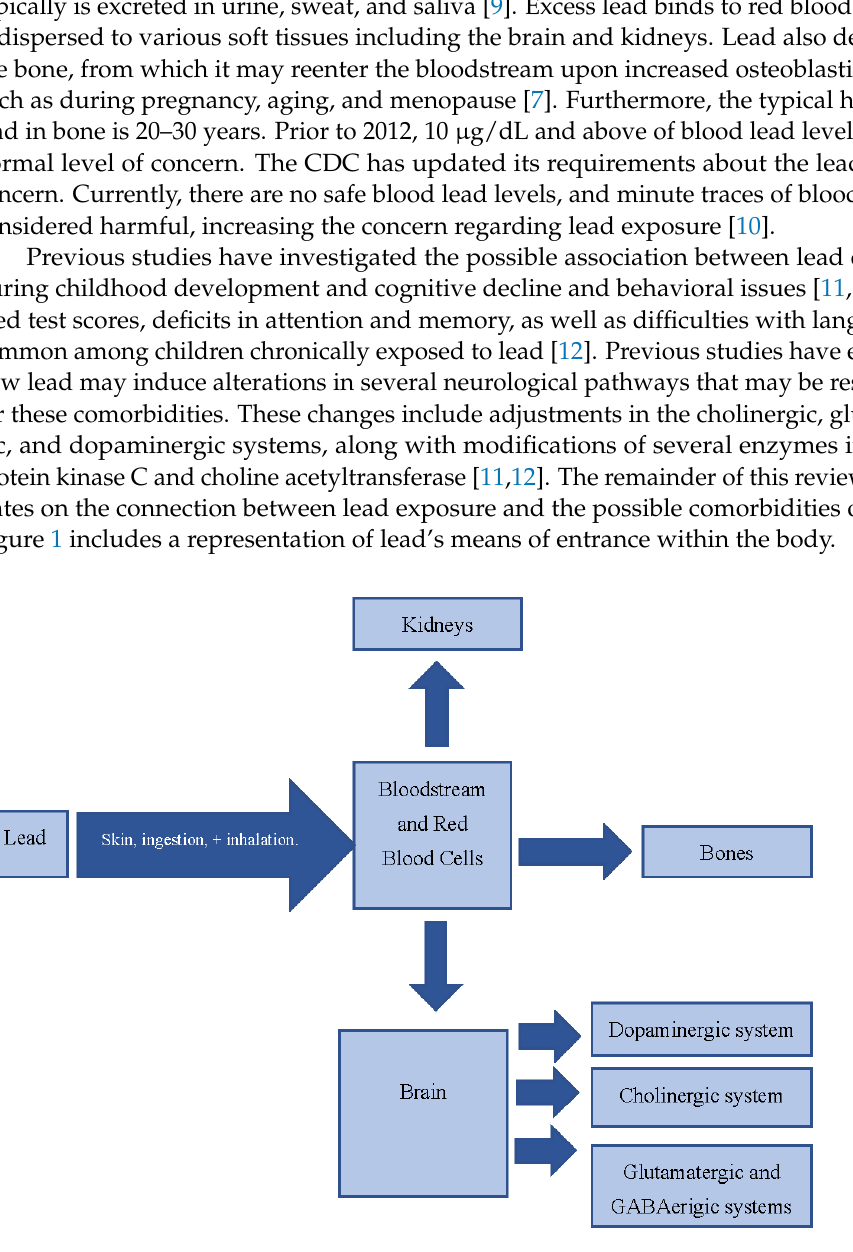
Figure 1. Representation of the routes of lead in the body.